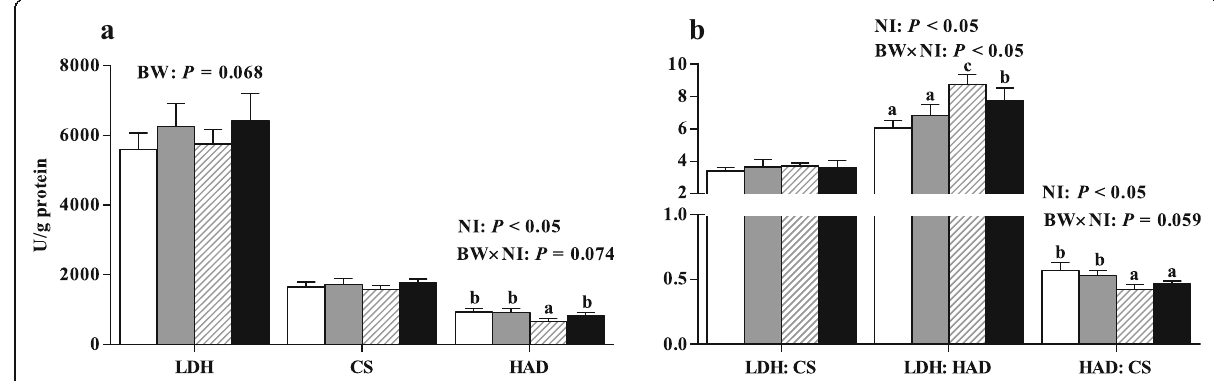
Fig. 1 Effects of the level of nutrient intake on activities of LDH, CS, and HAD ( a ) and the ratio of LDH:CS, LDH:HAD, and HAD:CS ( b ) in psoas major muscle of pigs with different birth weights. Values are means, with their standard errors represented by vertical bars ( n = 6 for each group). Mean values with different letters (a, b, c) were significantly different between four groups ( P < 0.05). , IUGR/ANI; , NBW/ANI; , IUGR/HNI; , NBW/HNI. ANI , adequate nutrient intake; HNI , high nutrient intake; IUGR , intrauterine growth restriction; NBW , normal birth weight; LDH , lactate dehydrogenase; CS , citrate synthase; HAD , β -hydroxy-acyl-CoA-dehydrogenase